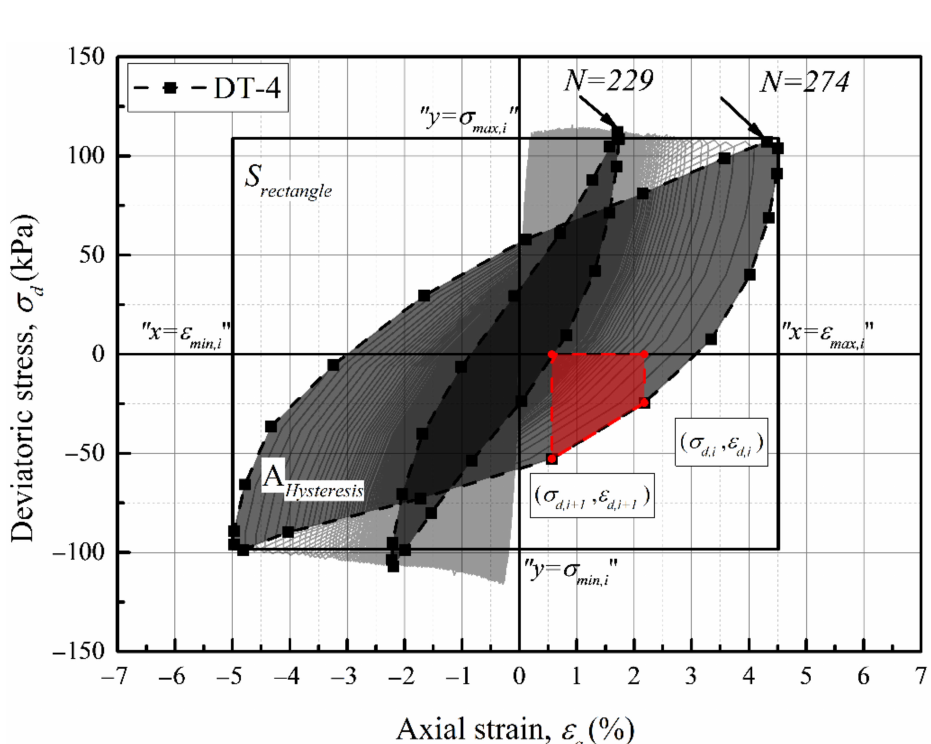
Figure 13. Typical hysteresis curve for calculation of viscous energy dissipation ratio